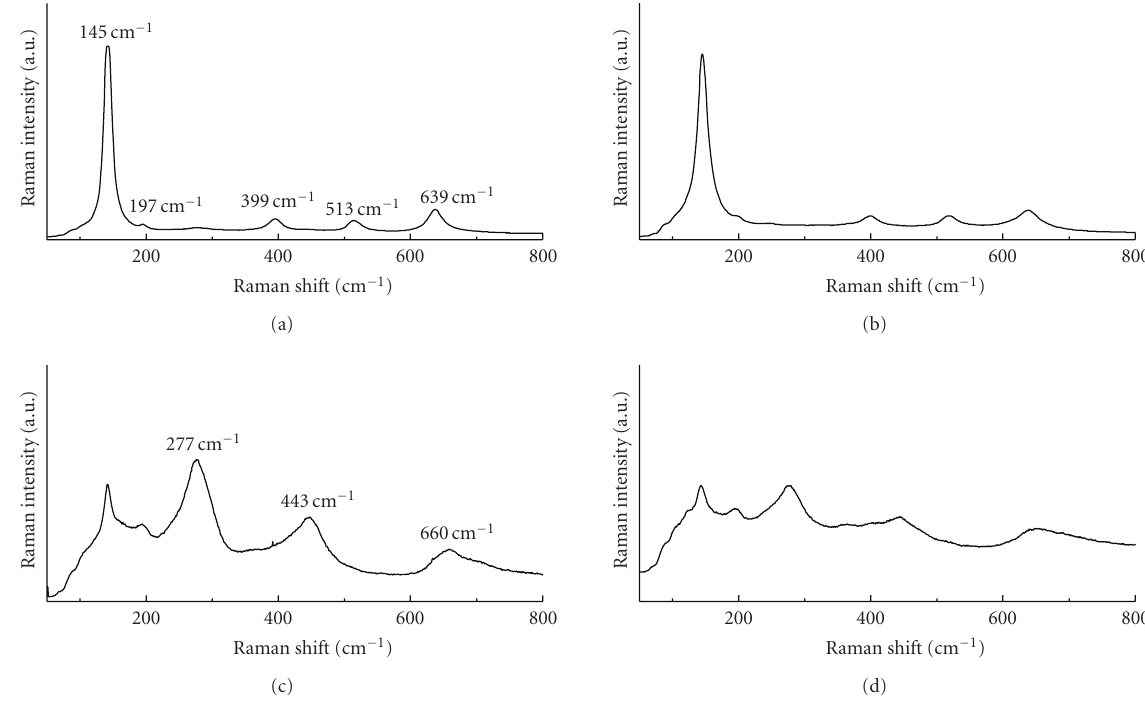
Figure 4: Raman spectra of: (a) Pure TiO 2 ; (b) 5% Gd 3+ -TiO 2 ; (c) Pure TNT; (d) 5% Gd 3+